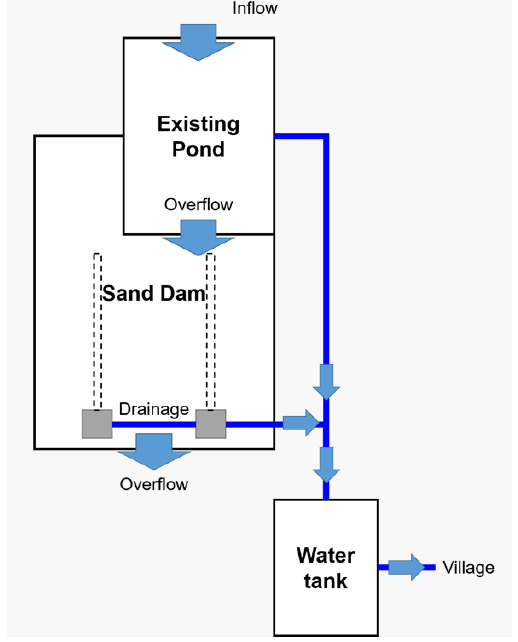
Figure 6. Schematic diagram of water supply system for the study area.